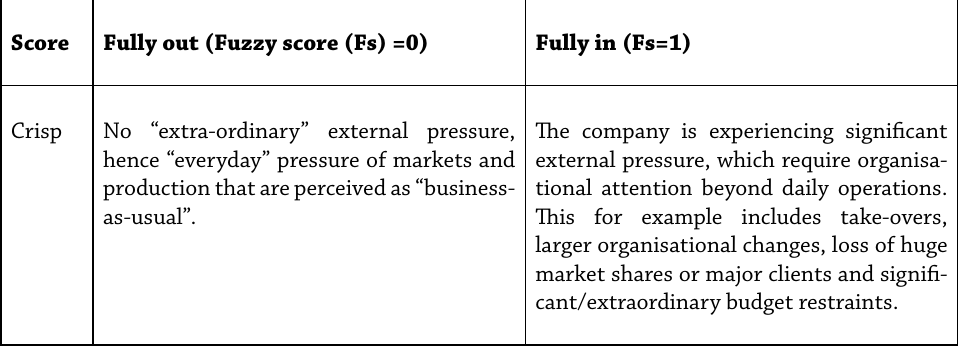
Table 5: Calibration of external pressure Score Fully out (Fuzzy score (Fs) =0) Fully in (Fs=1)